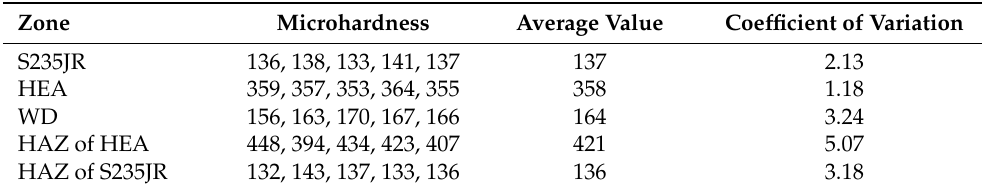
Figure 9. Hardness profile in the regions of the welded joint. Table 4. Microhardness values, HV 0.2 .